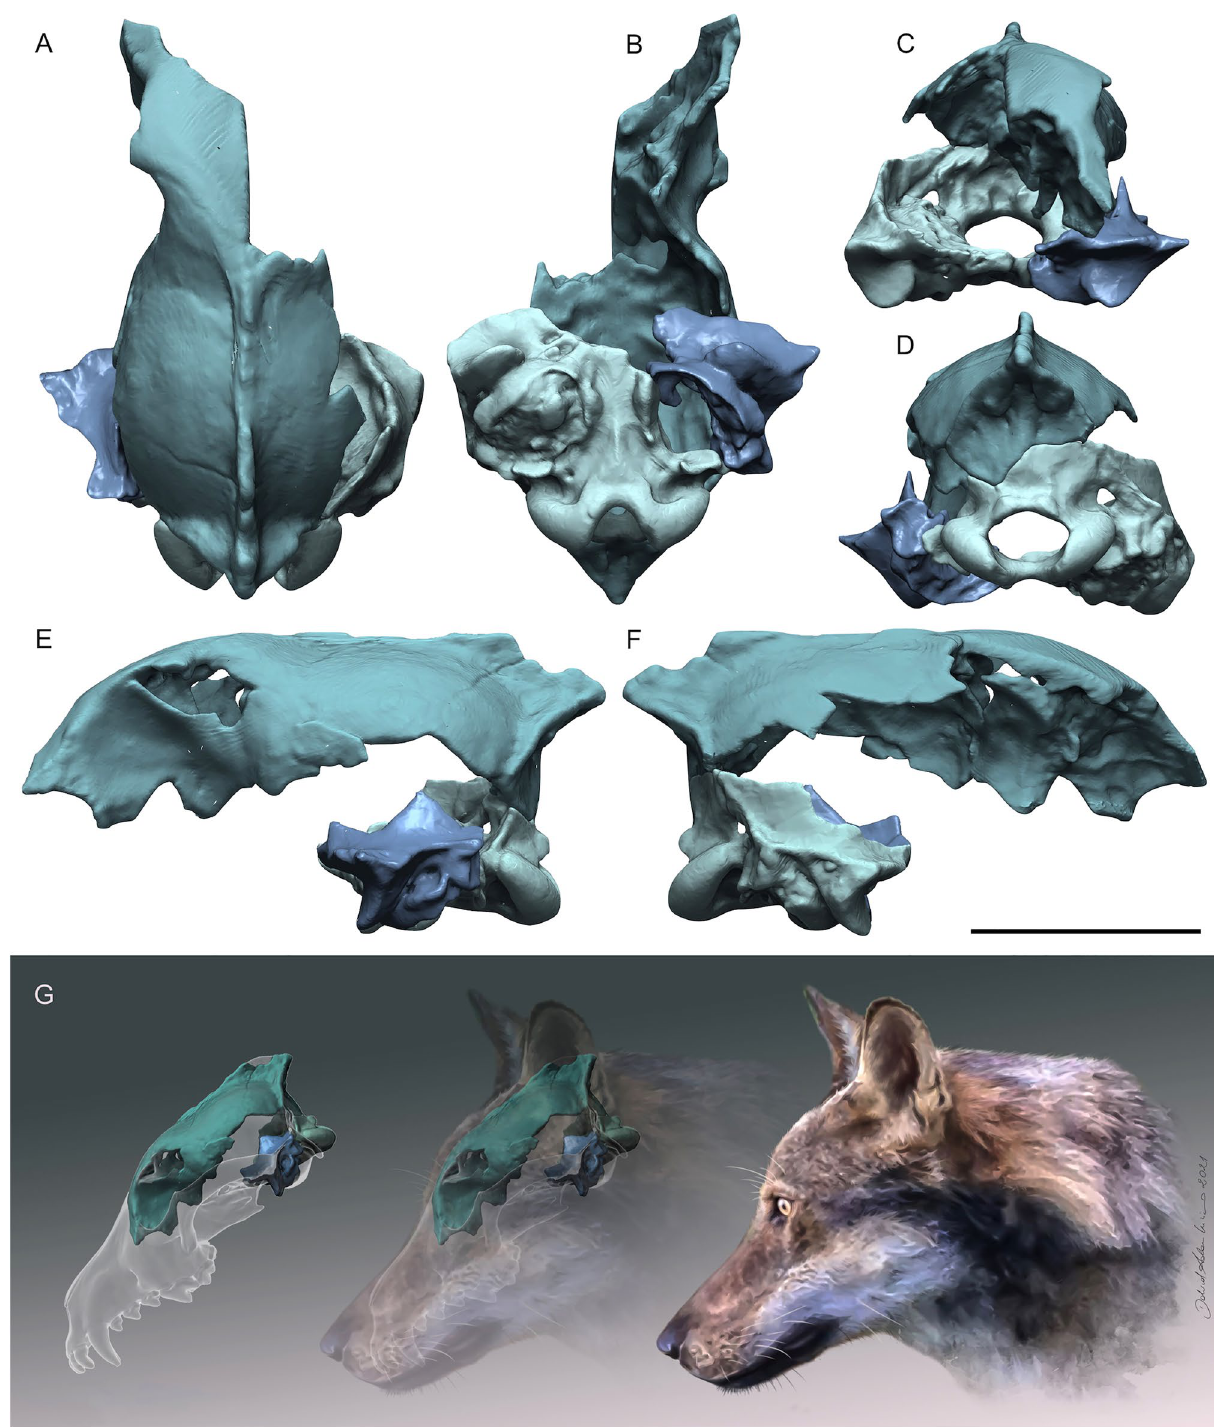
Figure 4. Virtually restored model of PF-PG1 specimen from Ponte Galeria in dorsal ( A ), ventral ( B ), anterior ( C ), posterior ( D ), left lateral and right lateral views. Scale bars: 50 mm. Reconstruction sequence of the head appearance of PF-PG1. Artwork by D.A.